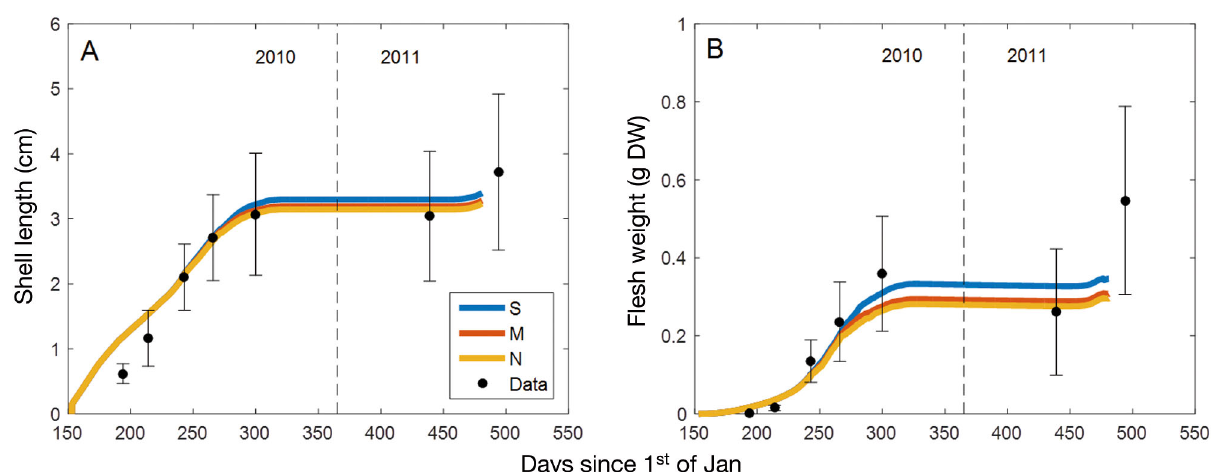
Fig. 4. Measured data and modelled (A) shell length and (B) biomass of individual blue mussels from the southern (S), middle (M) and northern (N) sections of the mussel mitigation culture unit from June 2010 to May 2011. Measured data represent a mixture of mussels from sections S, M and N, as no significant difference between sections was detected. Data are mean ±